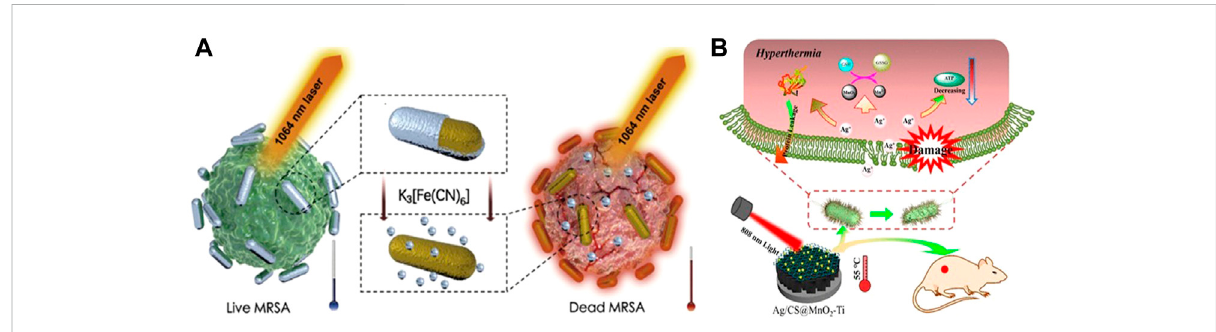
FIGURE 4 (A) SchematicdiagramofNIRIIcombinedwithreleasedAg +